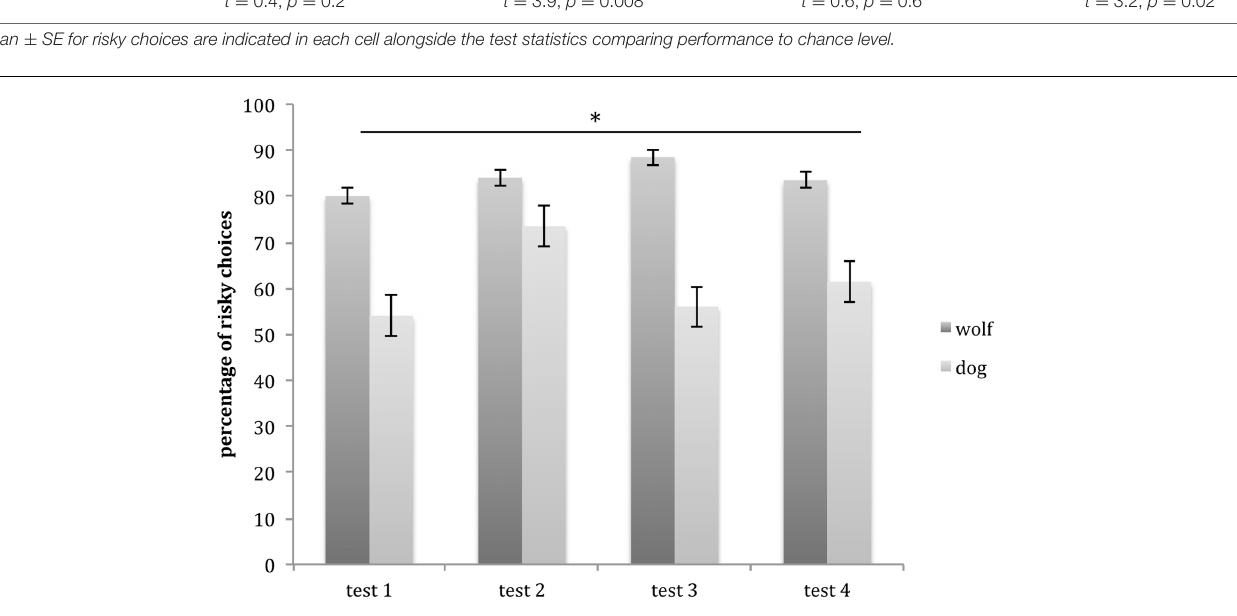
FIGURE 4 | Mean number of risky choices (and SE) carried out by wolves and dogs in test sessions. Wolves performed significantly more risky choices than dogs across all test trials. ∗ p <